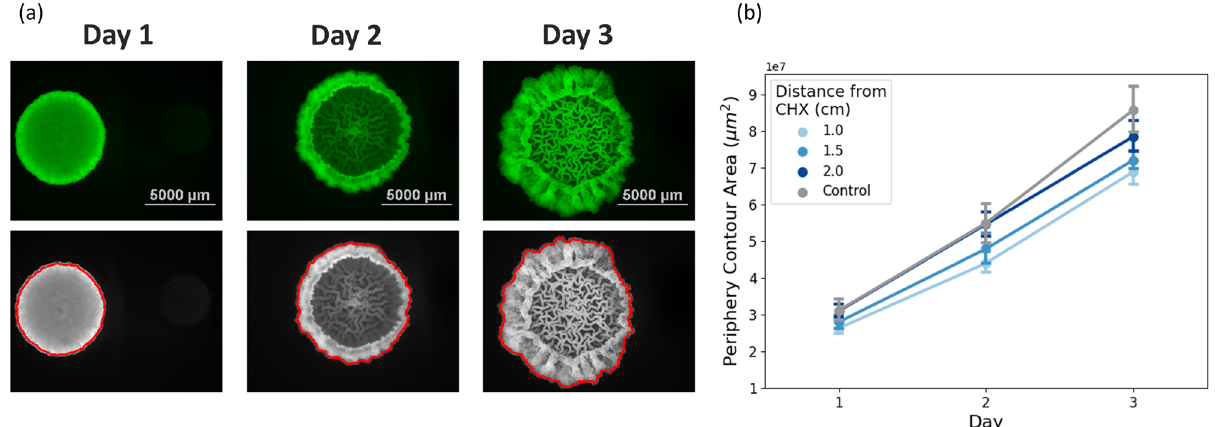
Figure 1. Macrocolony growth and expansion. ( a ) Fluorescent images of B. subtilis macrocolony development over a period of 3 days. CHX droplet is located horizontally to the right of the macrocolonies in each image, at a